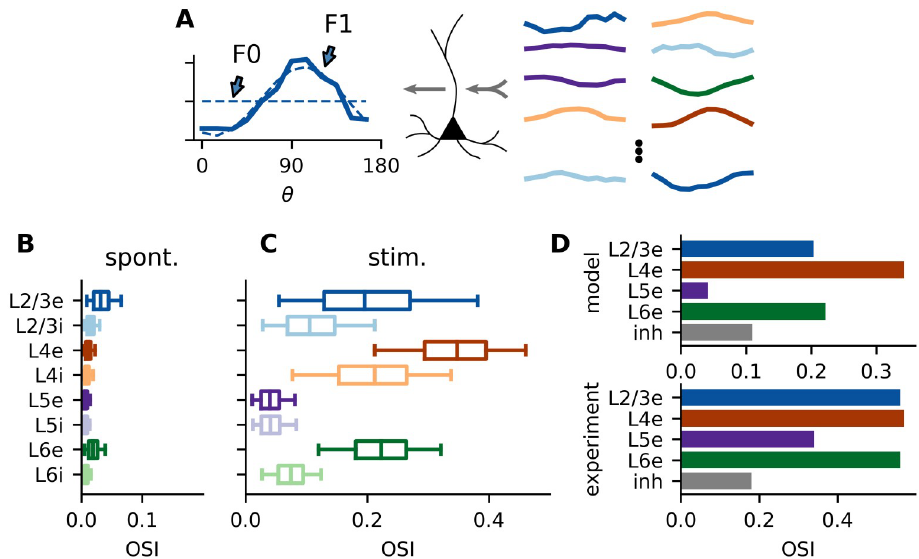
Fig 4. Orientation selectivity in the spiking neural network. A Every single neuron integrates its thalamic input with a large number of differently tuned inputs from various cortical populations (right) and generates tuned output from it (left). The orientation selectivity index (OSI) of the neuron is measured by the relative strength of the first (F1) as compared to the zeroth (F0) Fourier component of the output tuning curve (circular variance). B-C OSI quantified for neurons in all layers, measured both under spontaneous and stimulated conditions. Percentiles are the same as in Fig 2. D Comparison of mean orientation selectivities in the model with experimental values from [1].